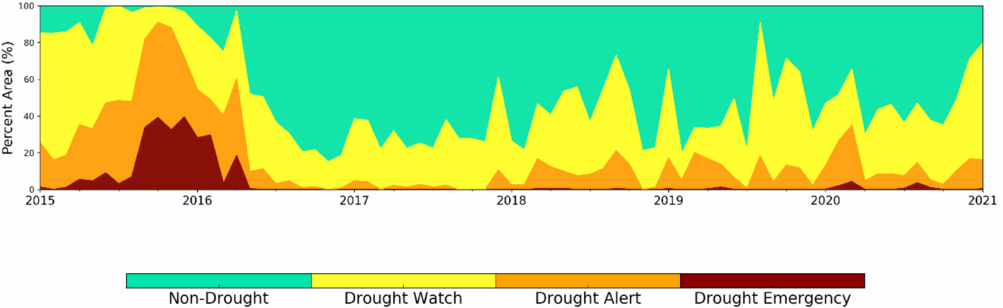
Figure 10. Drought warning maps for ( a ) September 2015 and ( b ) May 2016 (experimental product).